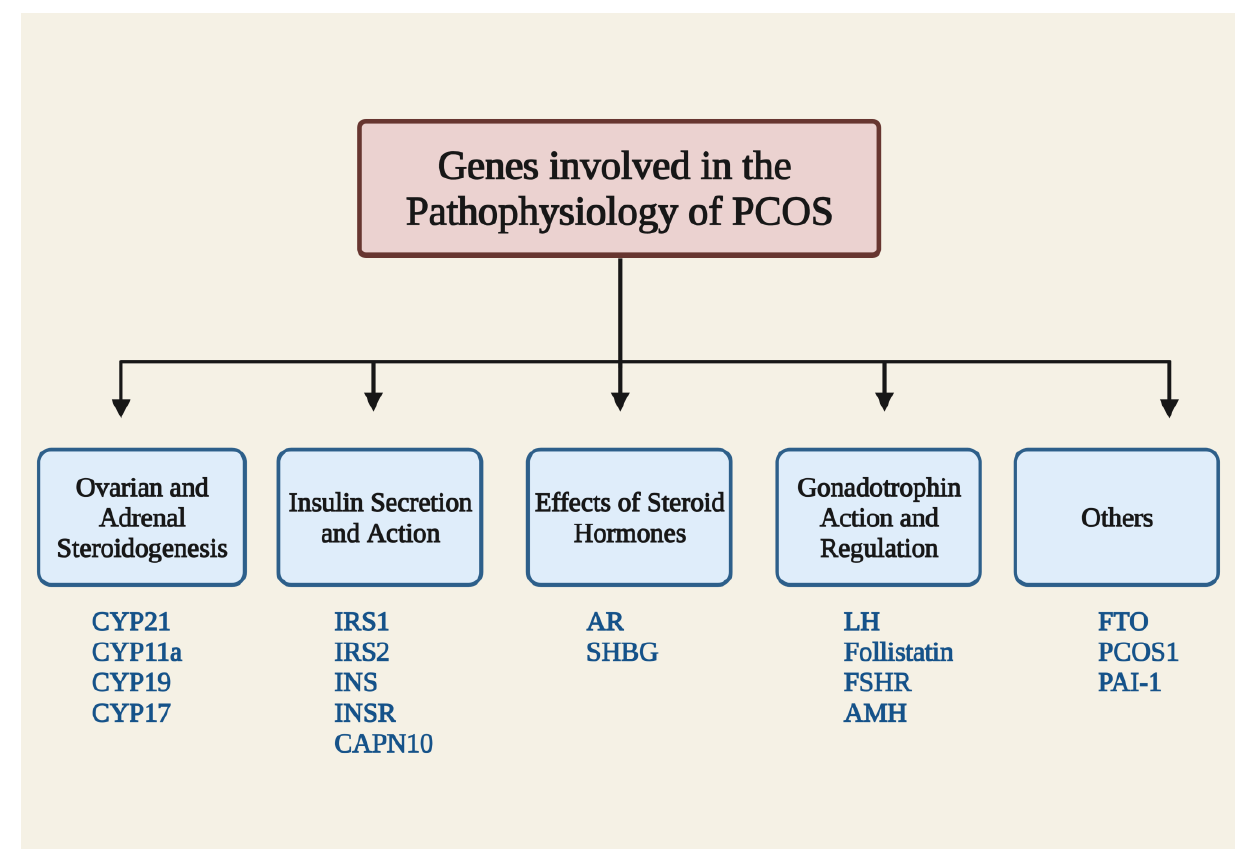
Figure 2. Summary of the genes involved in the pathophysiology of PCOS. CYP: cytochrome family p450; IRS: insulin receptor substrate; INS: insulin gene; INSR: insulin receptor; AR: androgen receptor gene; SHBG: sex hormone binding globulin; FSHR: follicle-stimulating hormone receptor; LH: lutein hormone; AMH: anti-Mullerian hormone; FTO: fat mass obesity; PAI-1: plasminogen activator inhibitor 1; and CAPN10: caplain-10.